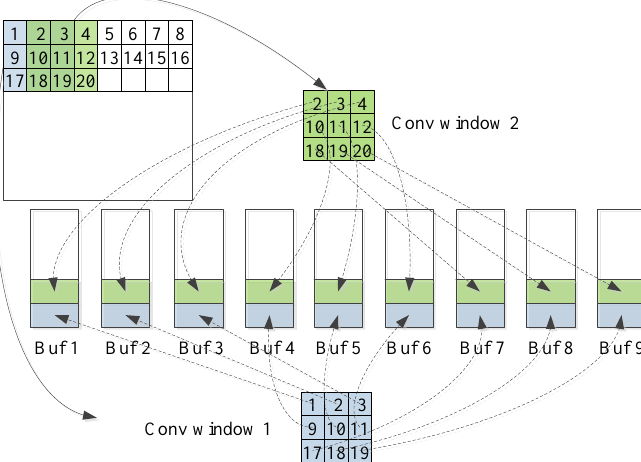
Figure 9. Array partitioning in T r and K dimensions.